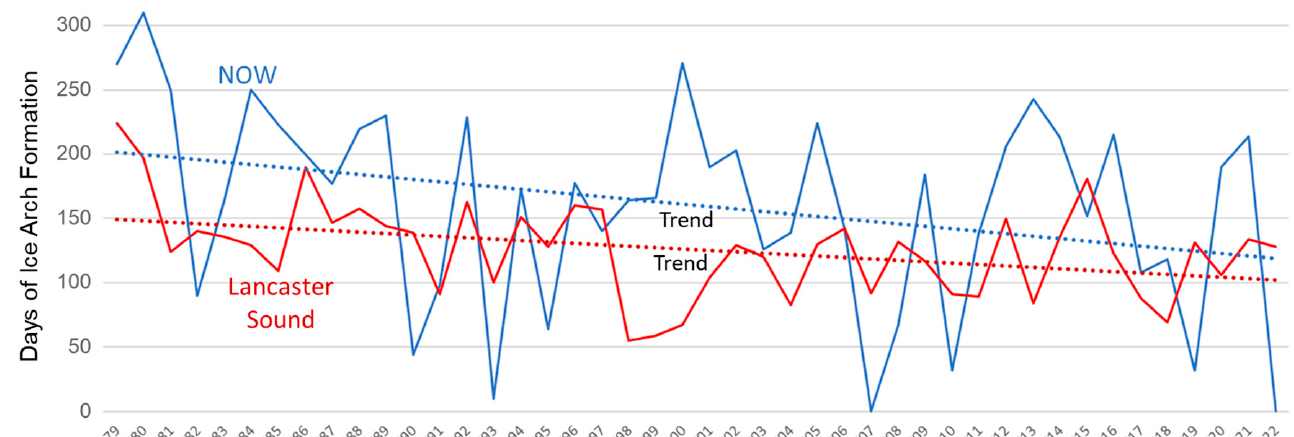
Figure 13. Days of ice arch formation and linear trends for the NOW (blue) and the Lancaster Sound polynya (red) from 1979 to 2022. Both datasets are highly variable, with an overall downward trend of ice arch duration since 1979. Some peaks and valleys in the graphs align, but overall, there is only a weak positive correlation from 1979 to 2000 and negligible correlation from 2000 to 2022.